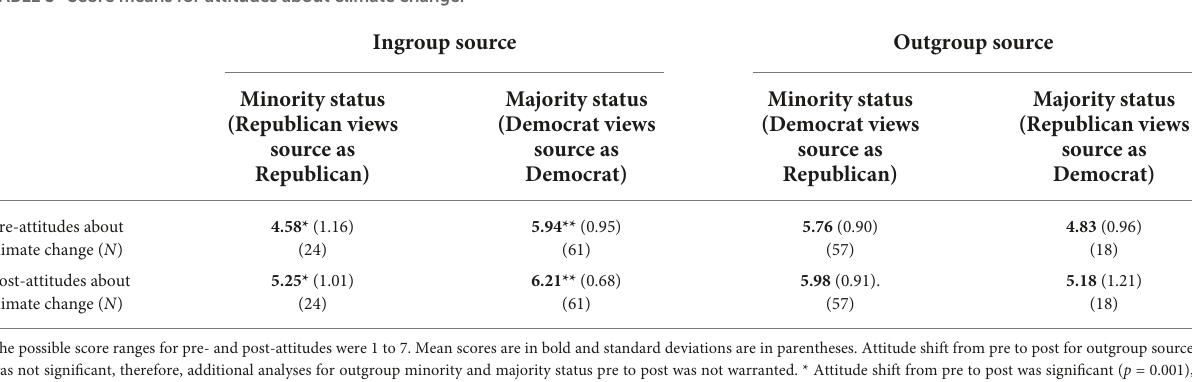
TABLE 3 Score means for attitudes about climate change.